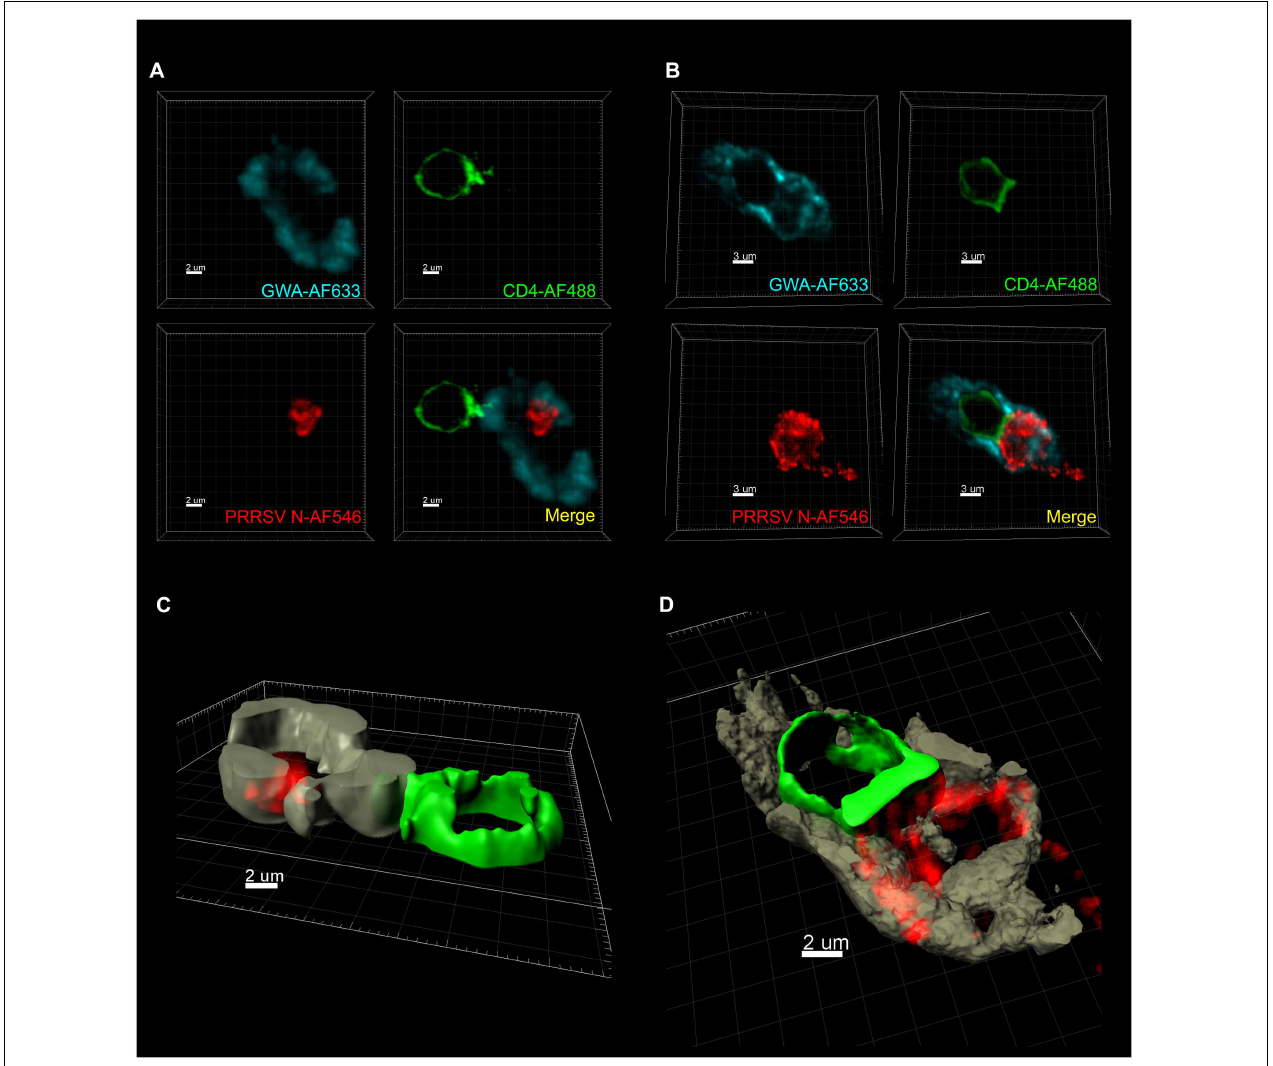
FIGURE 6 | Porcine reproductive and respiratory syndrome virus-infected MØ are in tight contact with pDC during co-culture. MØ were infected with PRRSV Lena for 90 min followed by wash steps and then co-cultured with pDC during another 16 h. Then MØ cell membrane was labeled with GWA-AF633 (turquoise in A , B ; brown in C,D ), pDC surfaces were labeled with CD4-AF488 (green), and PRRSV N protein (red) was stained with SDOW17-A-AF546. 3D scans were acquired using confocal microscopy. (A,B) Two different types of the cell-to-cell contact were observed. All micrographs are 3D Blend images with threshold subtraction and gamma correction set as in mock-treated MØ. The images were acquired with zoom together with optimum resolution format to provide the best voxel size for each employed fluorochrome. (C , D) 3D images were created using the surface module of the Imaris software applied on the labeling of GWA-AF633 and CD4-AF488 for the MØ and the pDC surfaces,